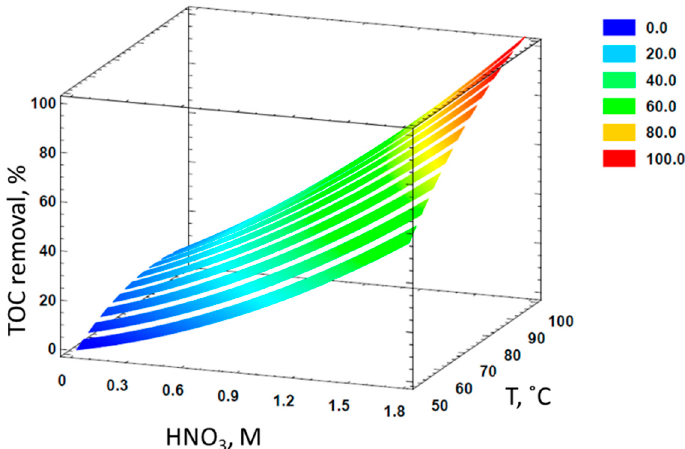
Figure 4. Response surfaces to assess the effect of both temperature and concentration of HNO 3 on TOC removal after 30 min of treatment, at a fixed dose of NaNO 2 of 100 mM.